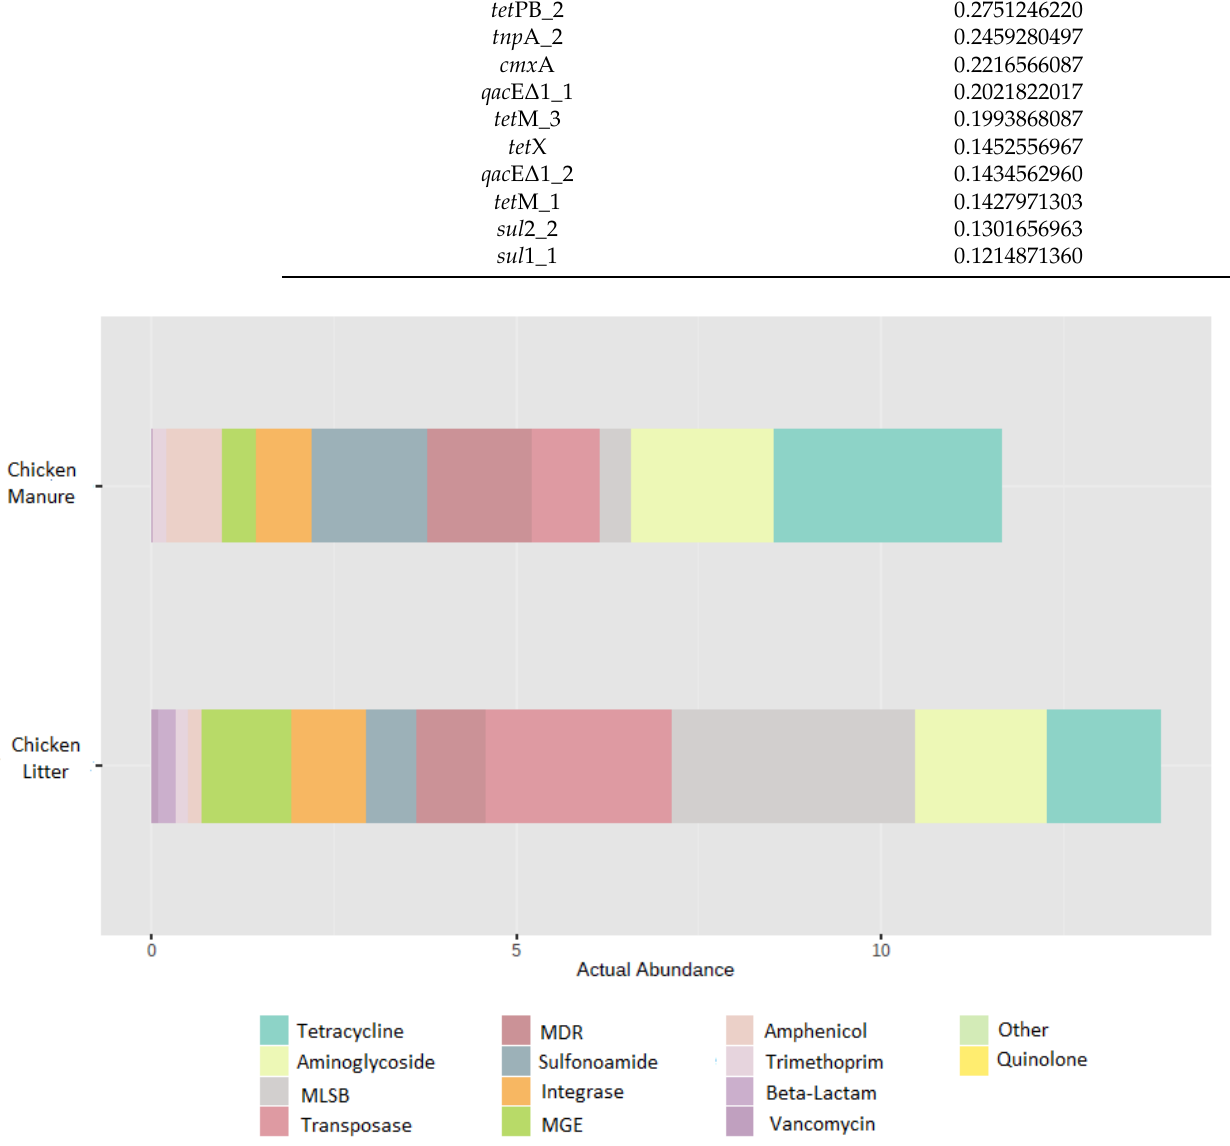
Figure 5. Relative abundance of the detected antibiotic-resistance gene groups, multi-drug resis- tance mechanisms, mobile genetic elements, integrase and transposase, visualized as gene copy number normalized per 16S rRNA gene copies. The visualization represents the mean value for three replicates.